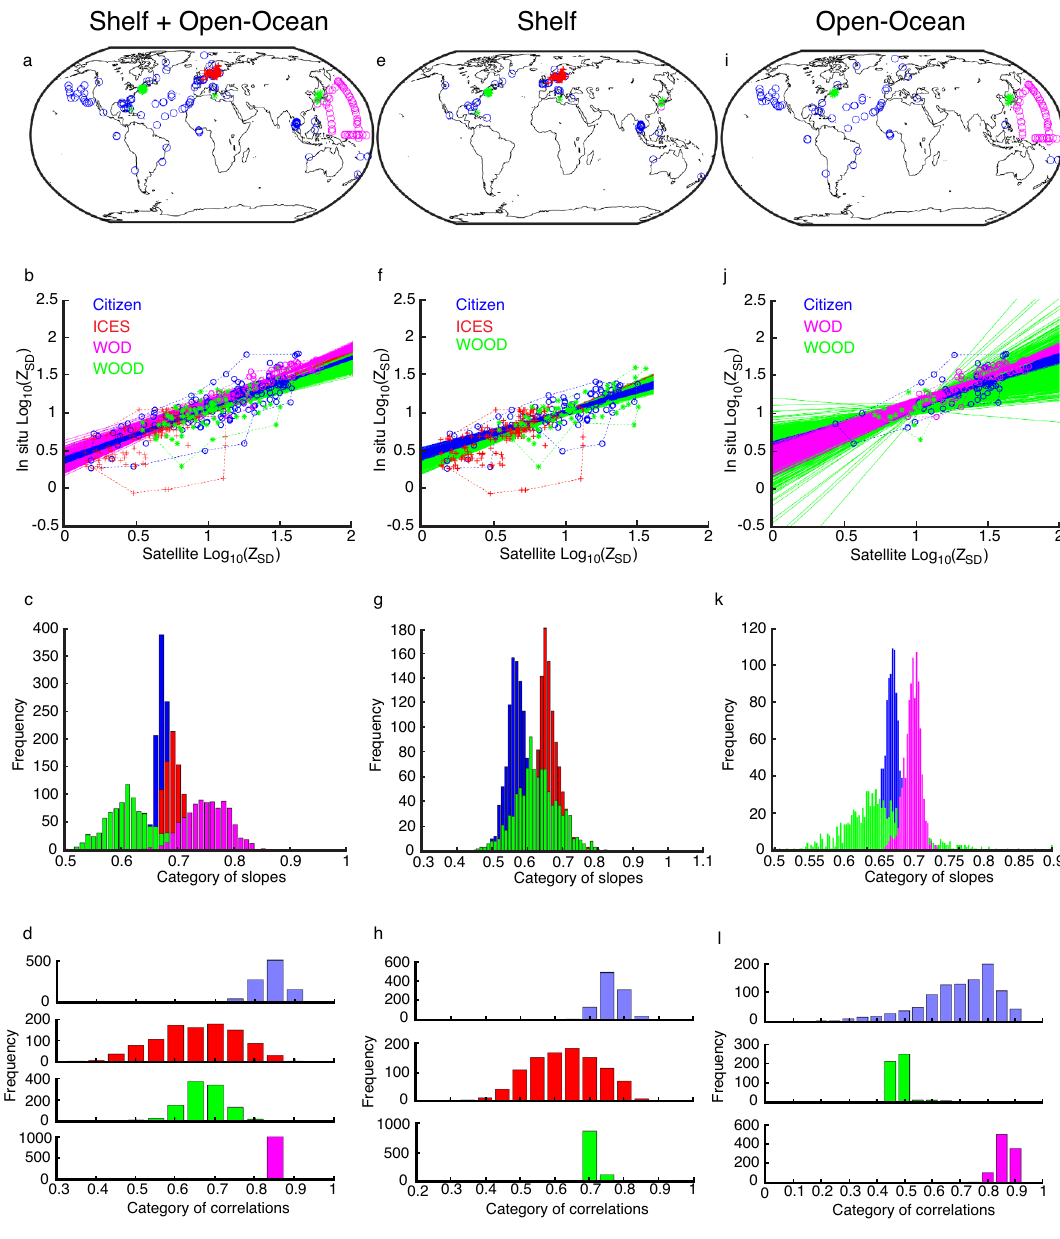
Figure 2. Relationships between WOD (magenta), WOOD (green), ICES (red) and citizen (blue) log 10 (Z SD ) and satellite log 10 (Z SD ). ( a,e,i ). Maps showing the positions of the WOD, WOOD, ICES, and citizen Z SD data for shelf + open-ocean, shelf, and open-ocean, respectively. Maps were created using MATLAB version 2021a, https:// www. mathw orks. com/ produ cts/ matlab. html. ( b,f,j ) Scatterplots, with red and blue polygons delineating the scientist and citizen data respectively, and regression lines showing the relationship between WOD, WOOD, ICES, citizen and satellite log 10 (Z SD ) for shelf + open-ocean, shelf, and open-ocean, respectively. ( c,g,k ) Histograms of regression coefficients between WOD, WOOD, ICES, citizen and satellite log 10 (Z SD ) for shelf + open-ocean, shelf, and open-ocean, respectively. ( d,h,l ) Histograms of the linear correlations between WOD, WOOD, ICES, citizen and satellite log 10 (Z SD ) for shelf + open-ocean, shelf, and open-ocean,